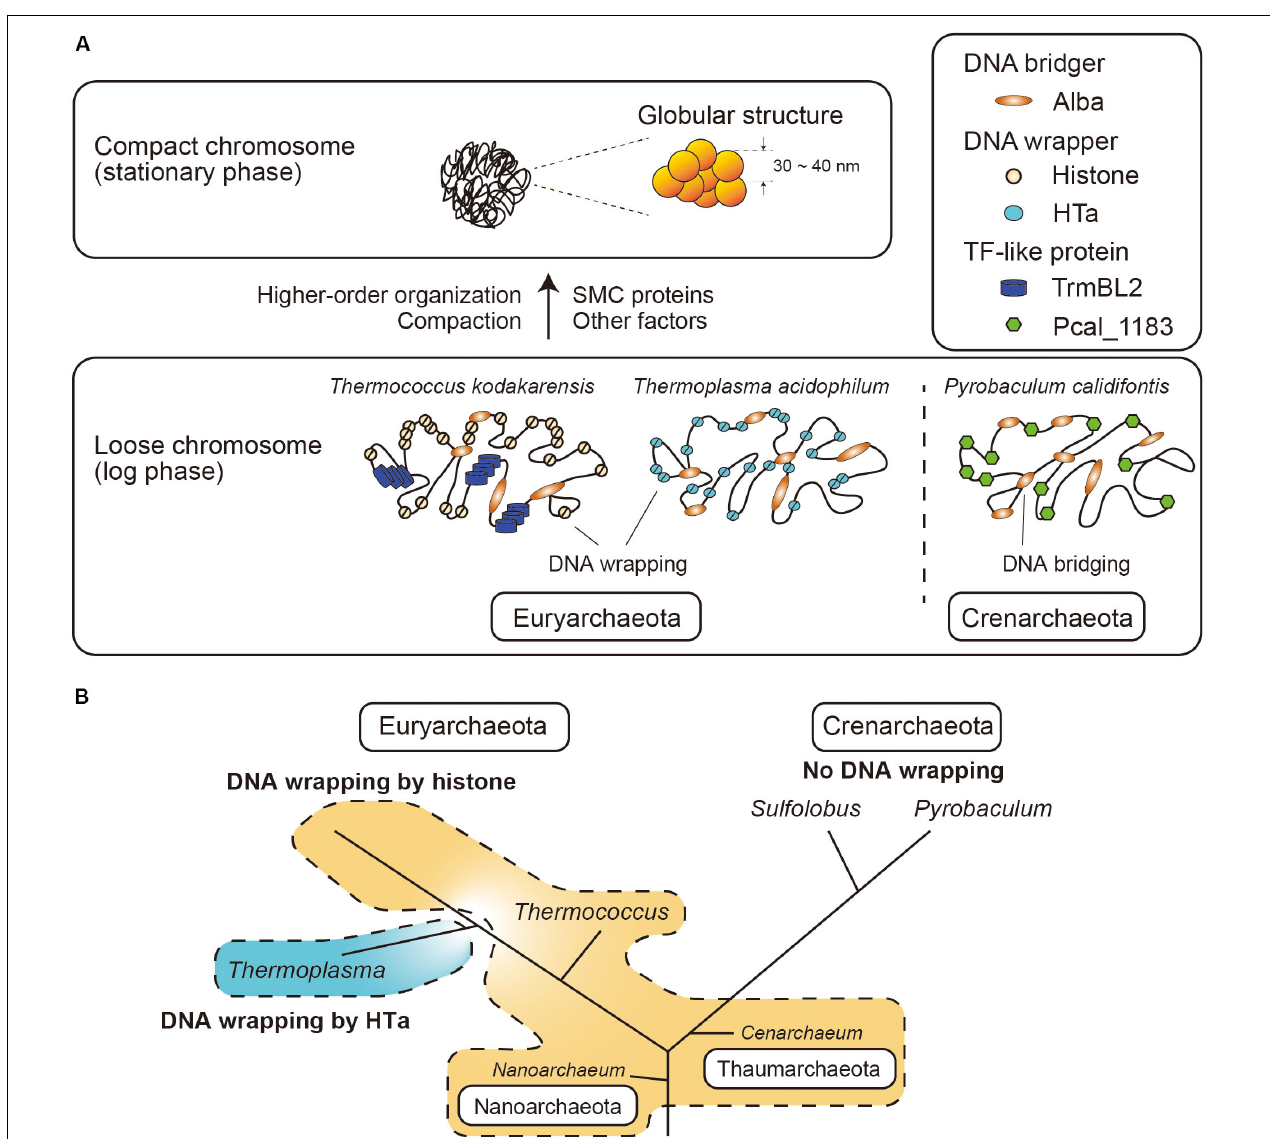
FIGURE 7 | Model of archaeal chromosome folding. (A) In Euryarchaeota, histone or HTa wraps genomic DNA, whereas there is no DNA wrapper in Crenarchaeota. Alba can bridge distant genomic DNA. Chromosome compaction occurs toward the stationary phase, when 30 ∼ 40-nm globular structures are formed. SMC proteins might be involved in higher-order organization of the chromosome. (B) Schematic phylogenetic tree of selected Archaea (Sandman and Reeve, 2005) together with the distributions of histone and HTa. Species in Euryarchaeota utilize histone or HTa ( Thermoplasmatales ) to wrap DNA at the primary level. Members of Nanoarchaeota and Thaumarchaeota also encode histone that might wrap DNA. Species in Crenarchaeota neither encode histone nor wrap DNA. The branch lengths do not correspond to evolutionary distances. Note that Cenarchaeum used to be classified as a member of Crenarchaeota, but is now considered a member of Thaumarchaeota (Spang et al.,